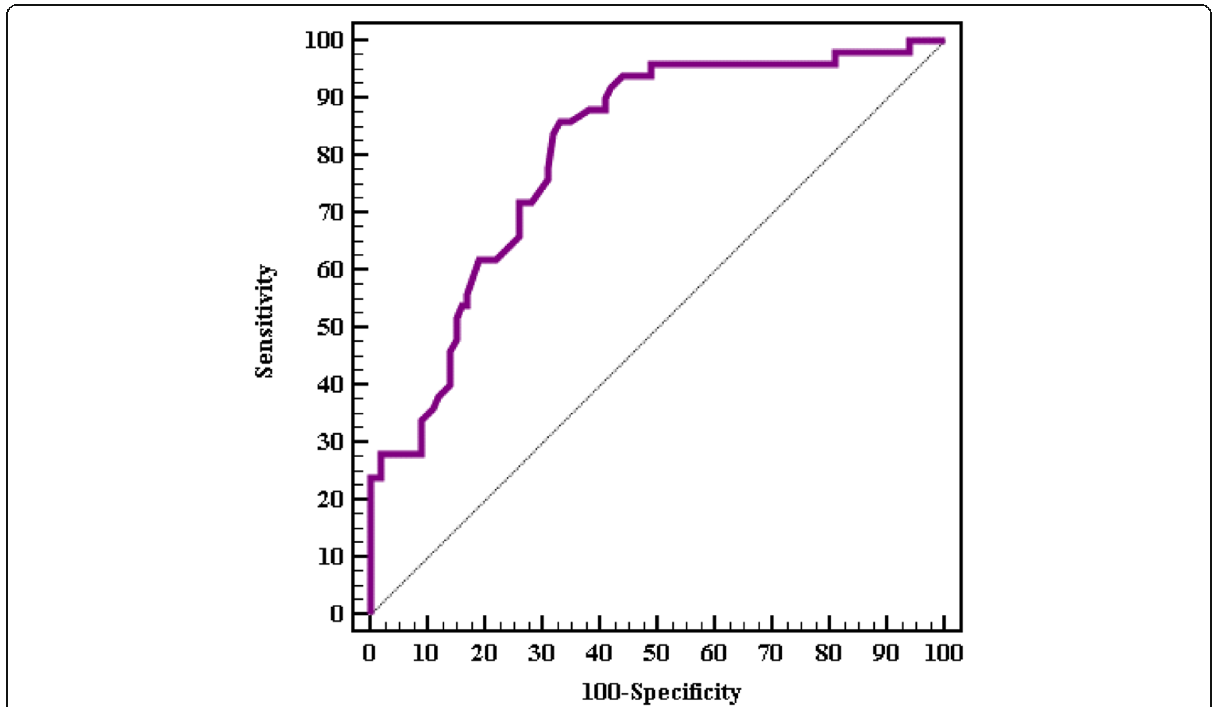
Fig. 3 ROC curve for miR-23b-3p to predict early-stage HCC patients (group II) from HCV-related cirrhosis (group I)